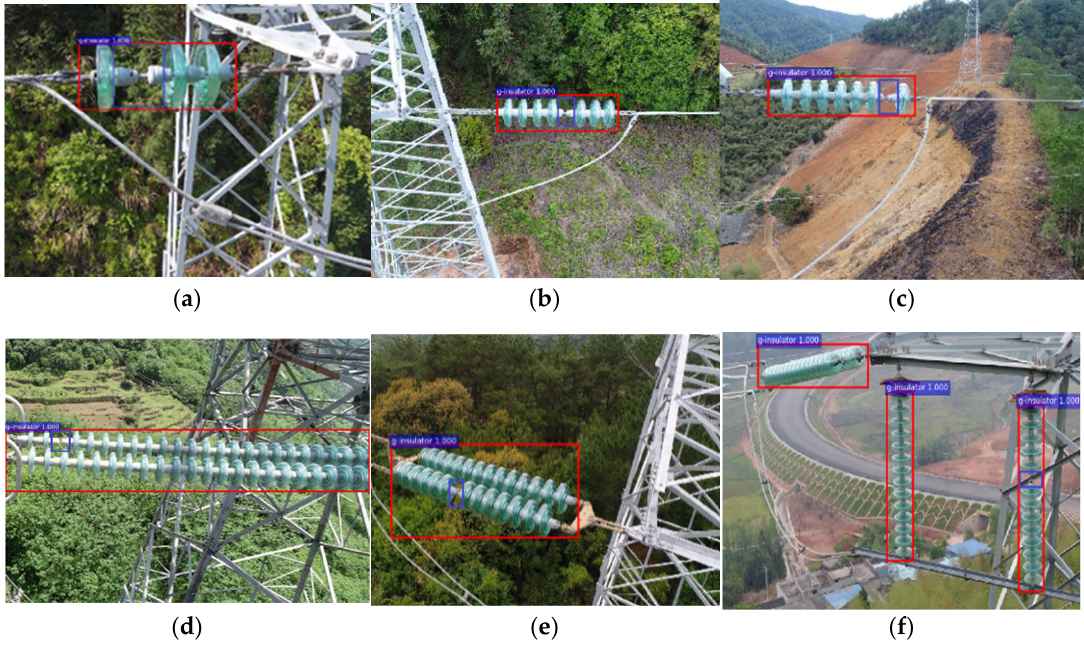
Figure 13. Verification results of insulator defect detection: ( a – f ) are the defect detection effects of insulators in different transmission towers